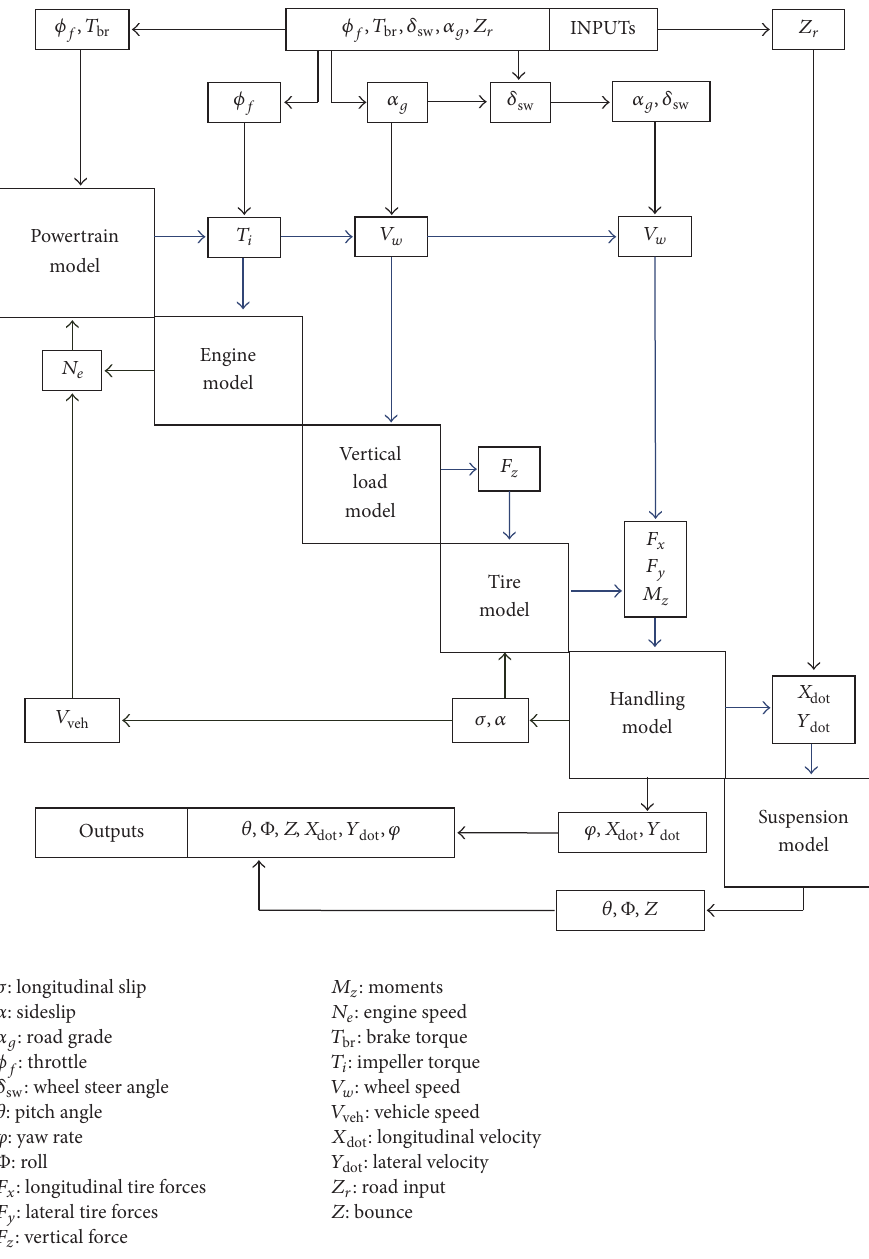
Figure 5: Ordered DSM of